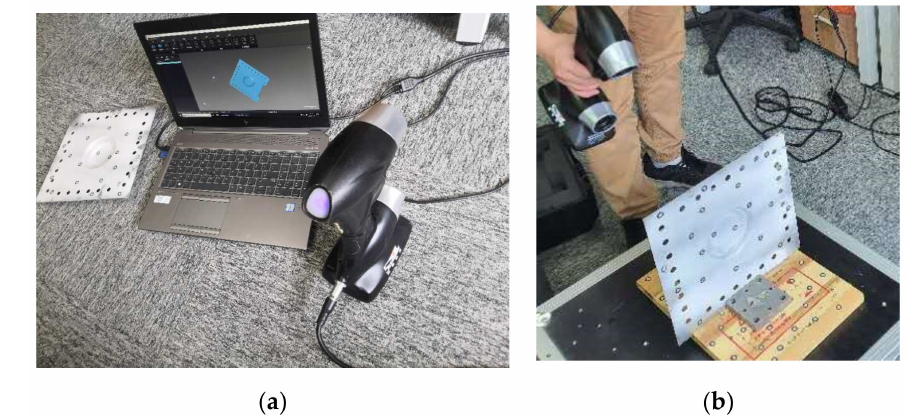
Figure 3. Forming device.